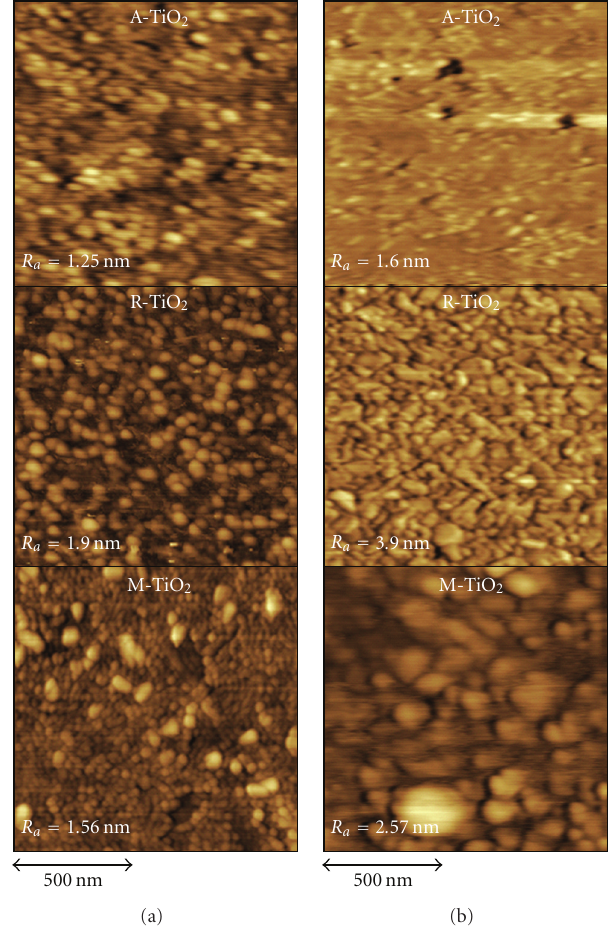
Figure 2: AFM top-view images of the unirradiated A-, R-, and M- TiO 2 thin film (a) and the irradiated A-, R-, and M-TiO 2 thin film with an N + ion dose of 5.0 × 10 15 ions/cm 2